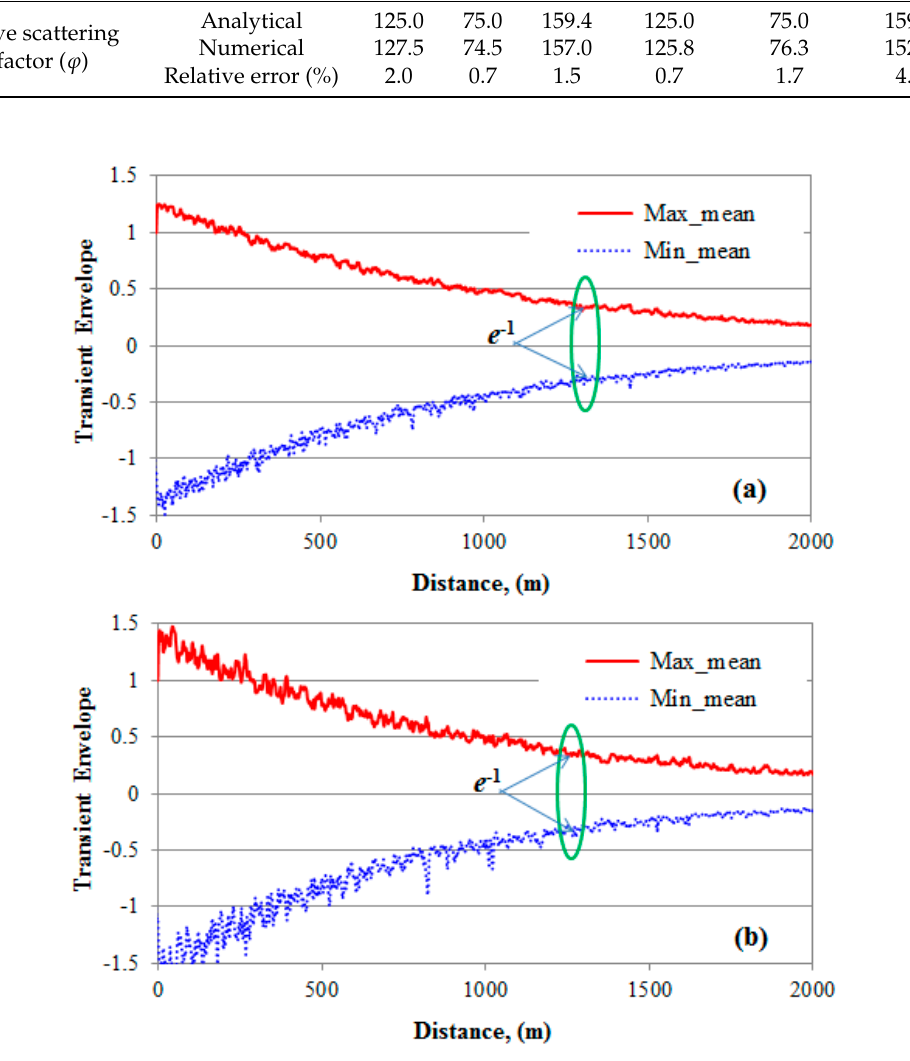
Figure 11. Results of the random disorder case with λ w /2 λ b > 1: ( a ) uniform distribution and α = 0.6 m − 1 ; ( b ) triangular distribution and α = 0.6 m − 1 . Table 2. Analytical and numerical results of the wave scattering factor.